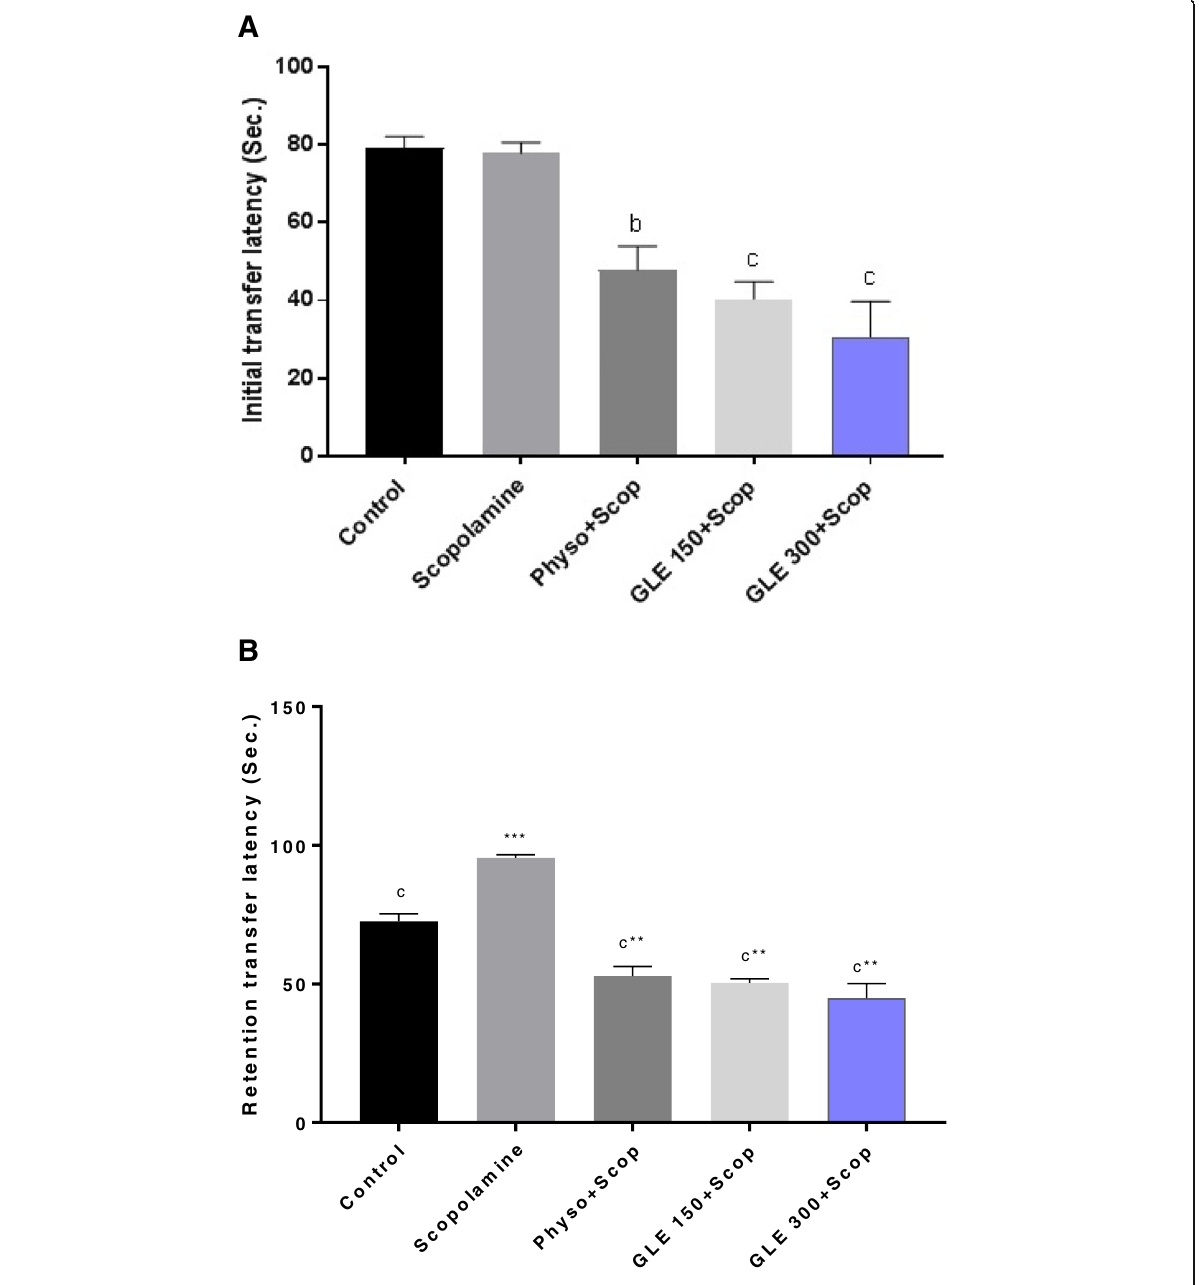
Fig. 1 a Effect of Ganoderma lucidum on Initial Transfer Latency (ITL) in EPM. Animals per group (n)=6; The values are mean±SEM (One-way ANOVA followed by Tukey ’ s Post hoc test). a p <0.05, b p <0.01, cp<0.001 when compared with scopolamine alone treated group. * p <0.05, ** p <0.01, *** p <0.0001 when compared with DW treated (control) group DW, distilled water; GLE 150, Ganoderma lucidum extract (150mg/kg); GLE 300, Ganoderma lucidum extract 300/kg; Scop, Scopolamine; Physo, Physostigmine. b Effect of Ganoderma lucidum on retention transfer latency (RTL) in EPM. Animals per group (n)=6; The values are mean±SEM (One-way ANOVA followed by Tukey ’ s Post hoc test). a p <0.05, b p <0.01, cp<0.001 when compared with scopolamine alone treated group. * p <0.05, ** p <0.01, *** p <0.0001 when compared with DW treated (control) group DW, distilled water; GLE 150, Ganoderma lucidum extract (150mg/kg); GLE 300, Ganoderma lucidum extract 300/kg; Scop, Scopolamine; Physo,